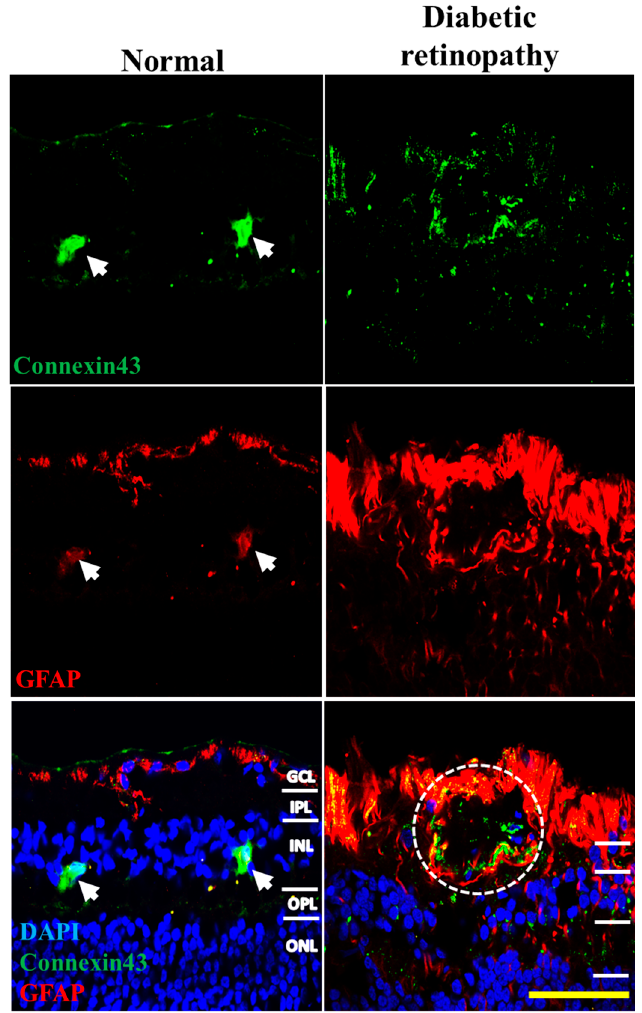
Figure 6. Connexin43 (green) and GFAP (red) expression in normal and human DR donor retinas in regions of extensive vascular damage. Large cells (white arrows, left column) represent non-specific auto-fluorescent amacrine cells. Connexin43 expression was markedly higher in the GCL of DR donor tissues compared to age-matched controls, and was strongly expressed throughout all retinal layers. GFAP labeling was also markedly higher in DR compared to normal donor eyes representing hyper-reactive Müller cells. Connexin43 expression was increased in regions identified as blood vessels and correlated with increased GFAP labeling at these sites, indicating glial cell activation (white circle). GCL = ganglion cell layer; IPL = inner plexiform layer; INL = inner nuclear layer; OPL = outer plexiform layer; ONL = outer nuclear layer. Scale bar: 200 µm.